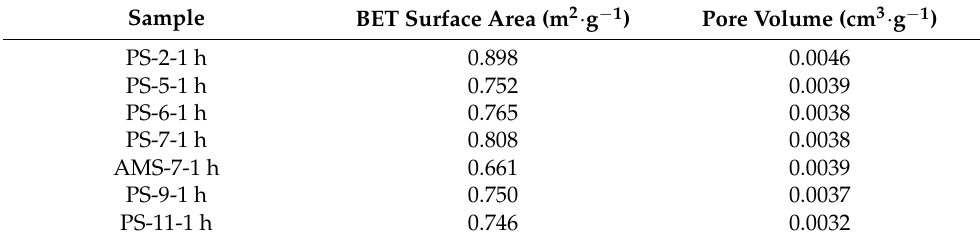
Figure 4. N 2 adsorption–desorption isotherms of the slag. Note: the legend means that the pristine slag (PS) and the aminopropyl-modified slag (AMS) were treated in the aqueous solution with a pH of 2, 5, 6, 7, 9 and 11 for 1 h, respectively, at room temperature. Table 6. The textual parameters of the slag.